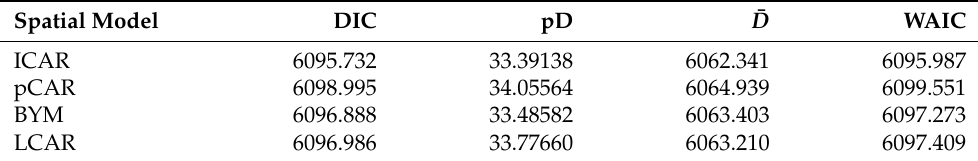
Table 1. Summary of DIC, pD, ¯ D and WAIC values for different spatial models used to fit the Bayesian hierarchical spatial models to HIV prevalence